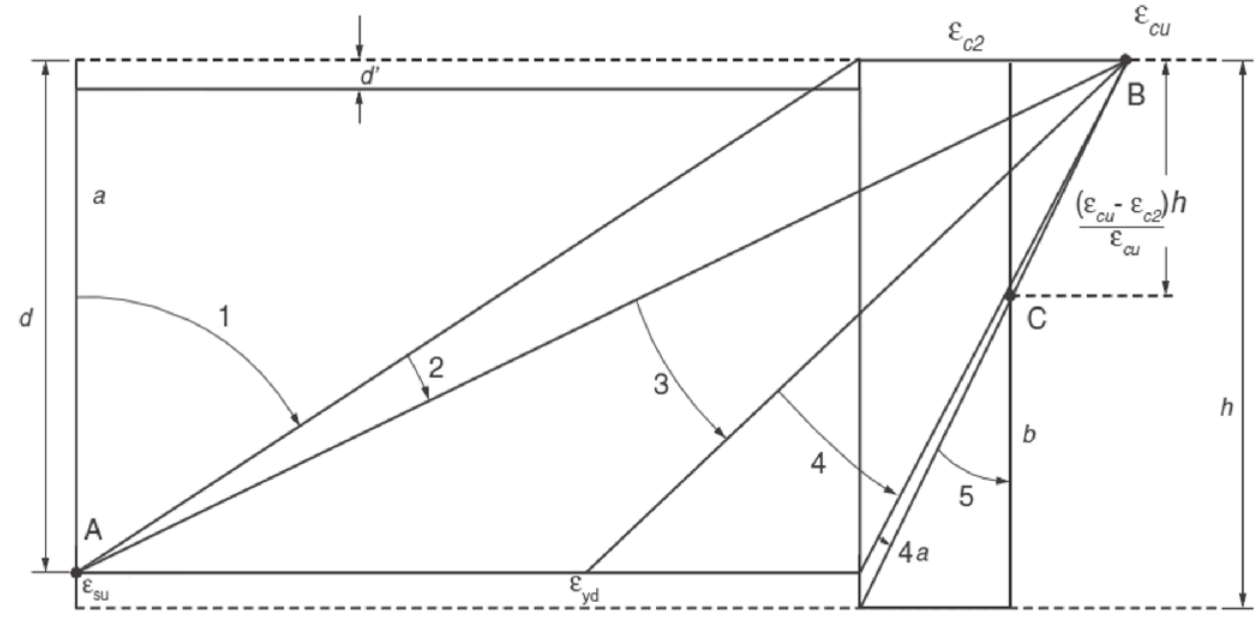
Domínios de deformação à temperatura ambiente